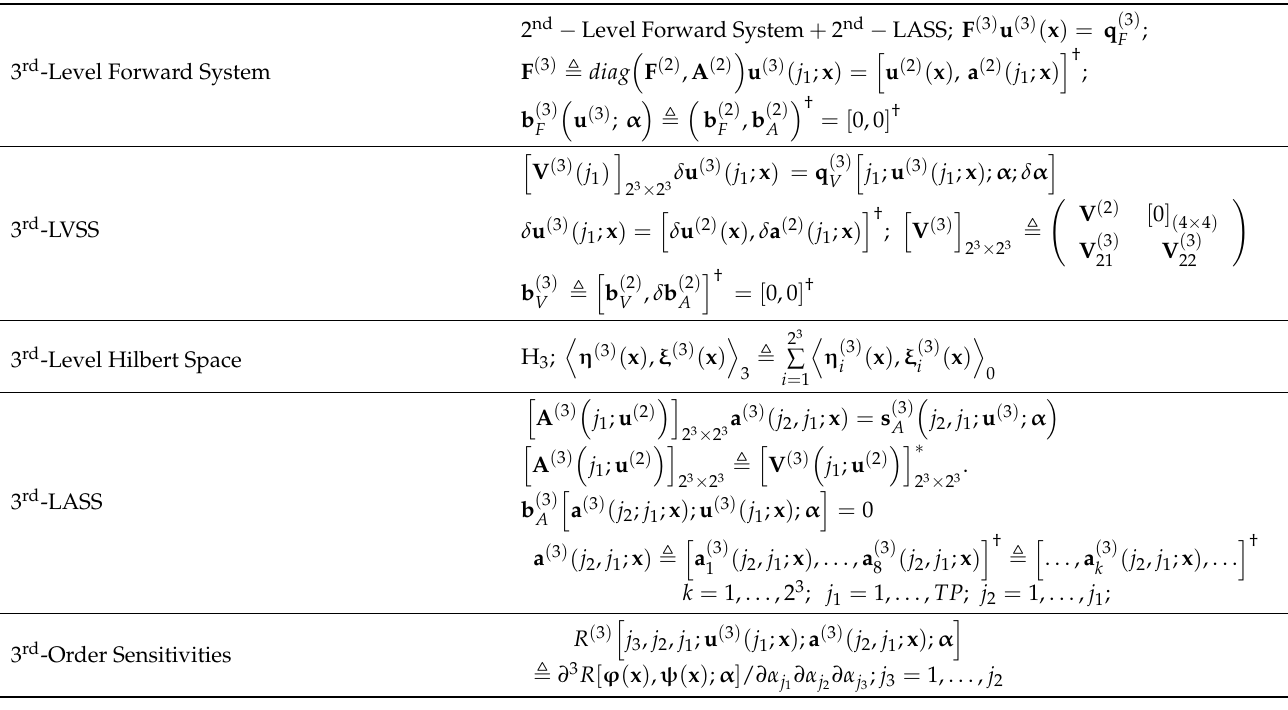
Table 3. Third-Order Sensitivities ( n = 3).